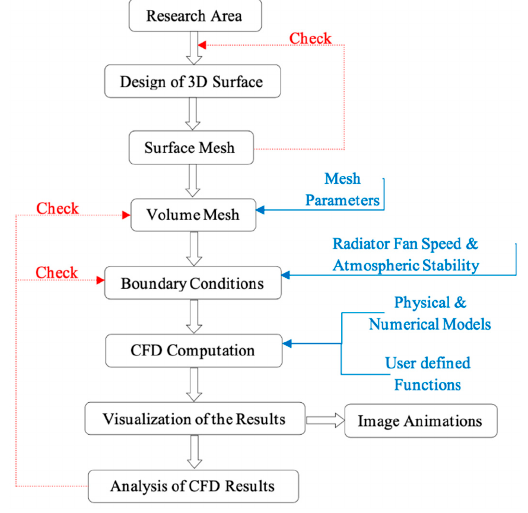
Figure 6. Methodology.